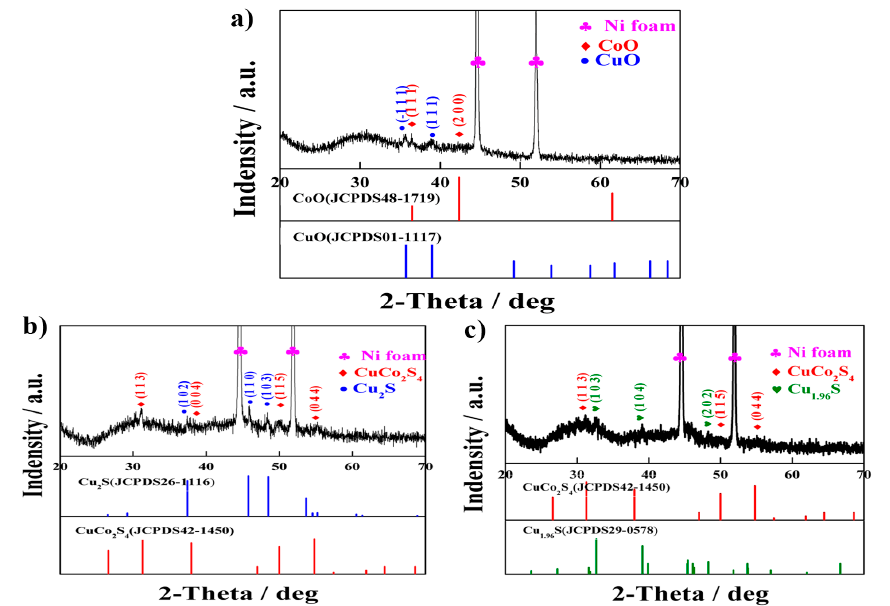
Figure 1. XRD patterns of sample on nickel foam, ( a ) Cu–Co oxide; ( b ) P–Cu–Co sulfide; ( c ) O–Cu–Co sulfide.